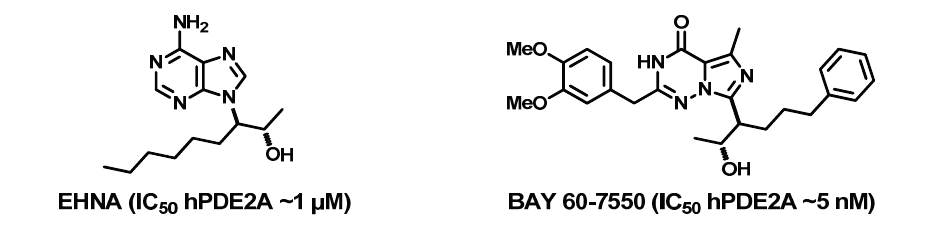
Figure 1. Most common PDE2A inhibitors: EHNA and BAY 60-7550